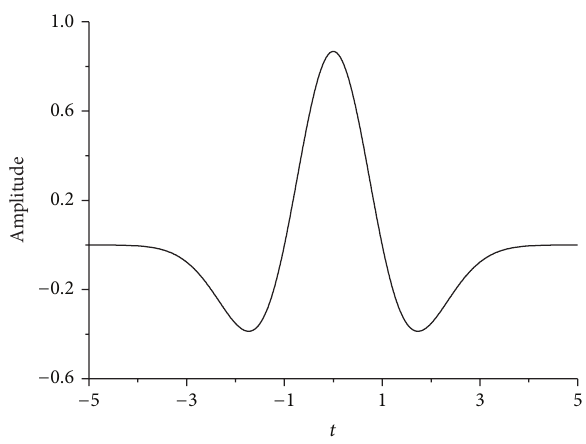
Figure 3: The Marr wavelet ( −𝜓(𝑡) and 𝜎 = 1